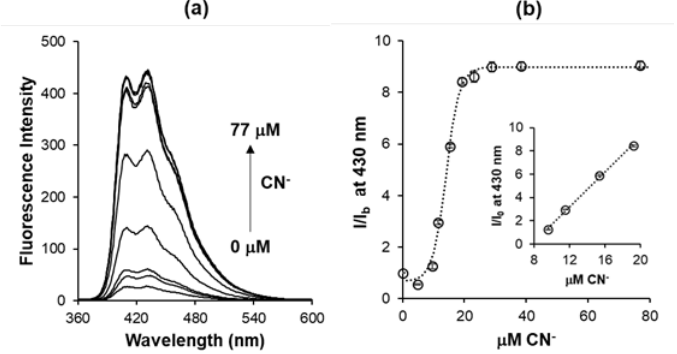
Figure 2. ( a ) Fluorescence emission spectra of 0.1 µ M sensor A (a 0.2 µ M 1 + 0.1 µ M 3 + 4 µ M Cu 2+ mixture) upon addition of increasing concentrations of CN − (0–77 µ M) in aqueous solution. ( b ) Fluorescence recovery (I/I b ) of 0.1 M sensor A (open circles) upon addition of CN - . The dashed line is a sigmoidal fit and is intended to guide the eye. The insert is the recovery plot in the linear dose response region. For all studies reported in Figure 2, error bars represent three standard deviations, the solvent used is 0.5wt% Triton X-100 in deionized water, and EX = 350nm. Sensor A is a 1+3+Cu 2+ complex with 2:1:40 ( 1:3:Cu 2+ ) stoichiometry.